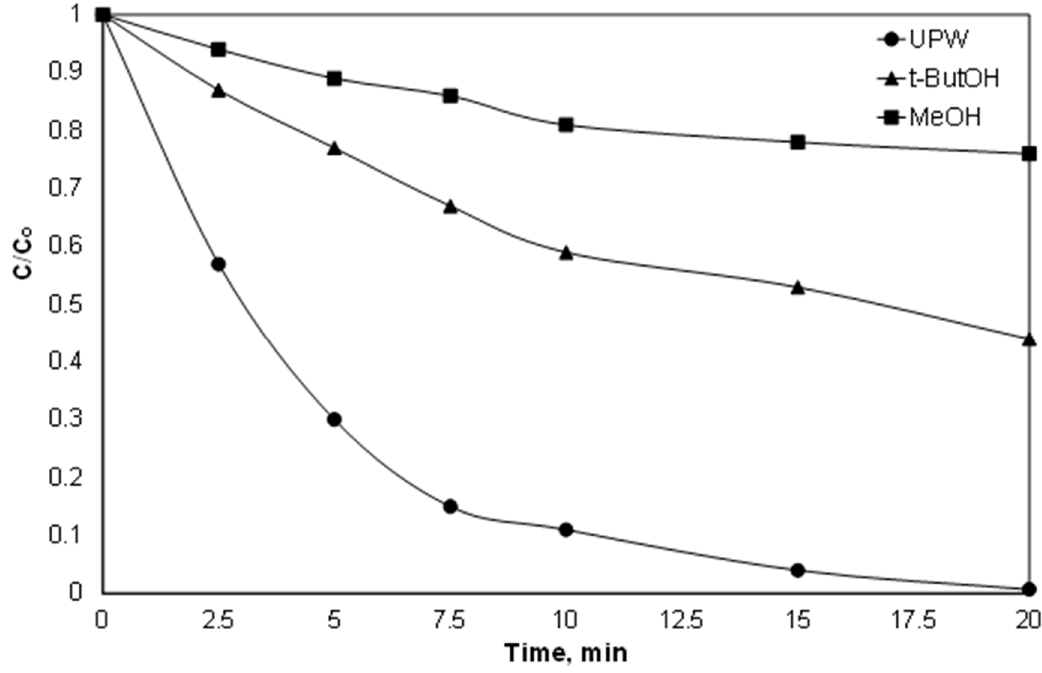
Figure 4. Effect of radical scavengers on the degradation of 1.5 µ M PIR at pH 6.5 and ultrapure water with 2 mg/L Fe 2+ , 84 µ M SPS and 42 mM of alcohols.